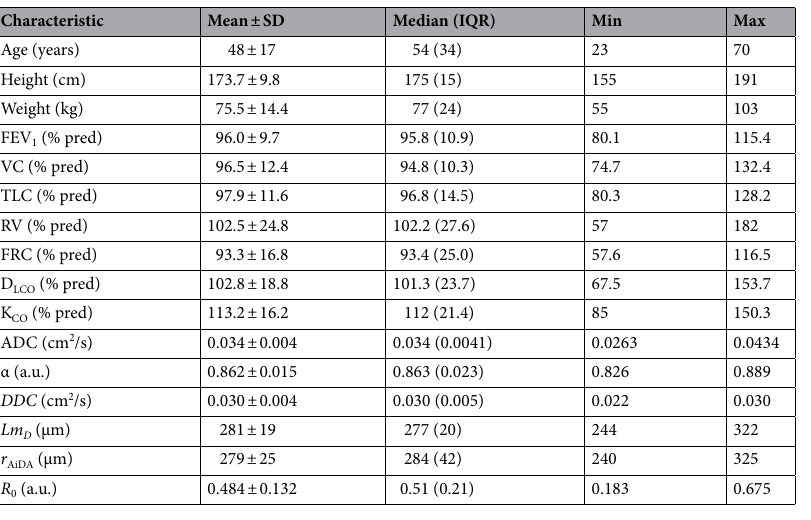
Table 1. Summary of volunteer demographics and global measurements. Data are presented as mean ± SD, median (IQR), minimum values and maximum values. IQR interquartile range, FEV 1 forced expiratory volume in 1 s, VC vital capacity, TLC total lung capacity, RV residual volume, FRC forced respiratory capacity; D LCO diffusing capacity of lung for carbon monoxide, K CO carbon monoxide transfer coefficient, ADC apparent diffusion coefficient, α heterogeneity index, DDC distributed diffusivity coefficient, Lm D mean diffusive length scale, r AiDA distal airspace radius, R 0 zero-second